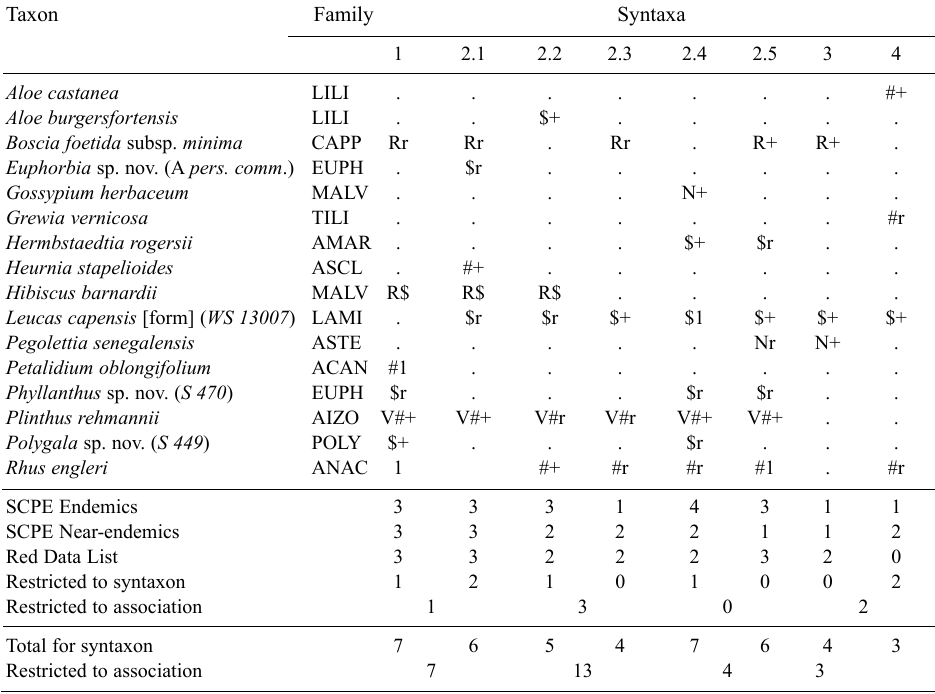
Sekhukhuneland Centre endemic/near-endemic and Red Data List plant taxa recorded for the Potlake Nature Reserve and surrounding areas Taxon